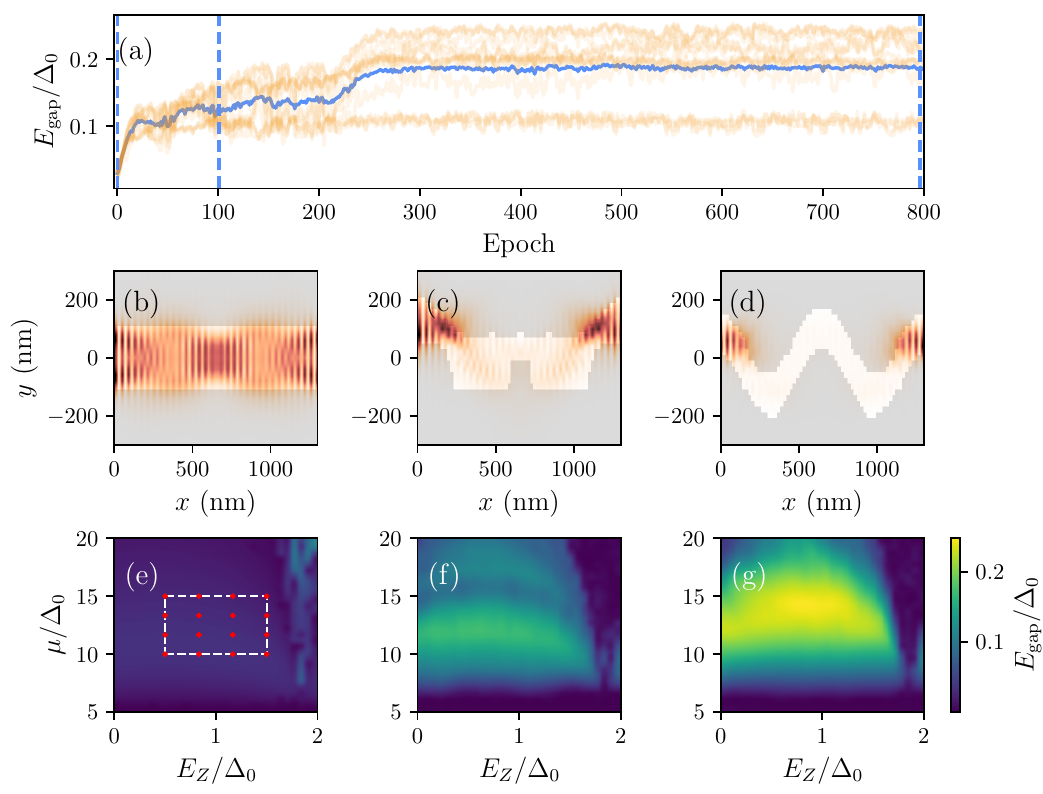
Figure 3: Optimization run starting from a straight geometry with homogeneous chemical potential and with parameter shifting and median filtering. (a) The blue curve corresponds to the average gap evaluated at 16 different points in parameter space, whose individual values we plot in orange. In panel (e) we mark these points with red dots. (b-d) Geometries found at the epochs marked with vertical dashed lines in panel (a). (e-f) Topological phase diagrams of the geometries in